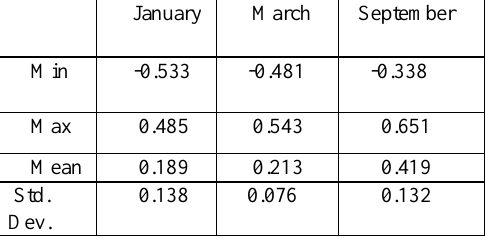
Table 5: Summary of NDVI during the three months observed